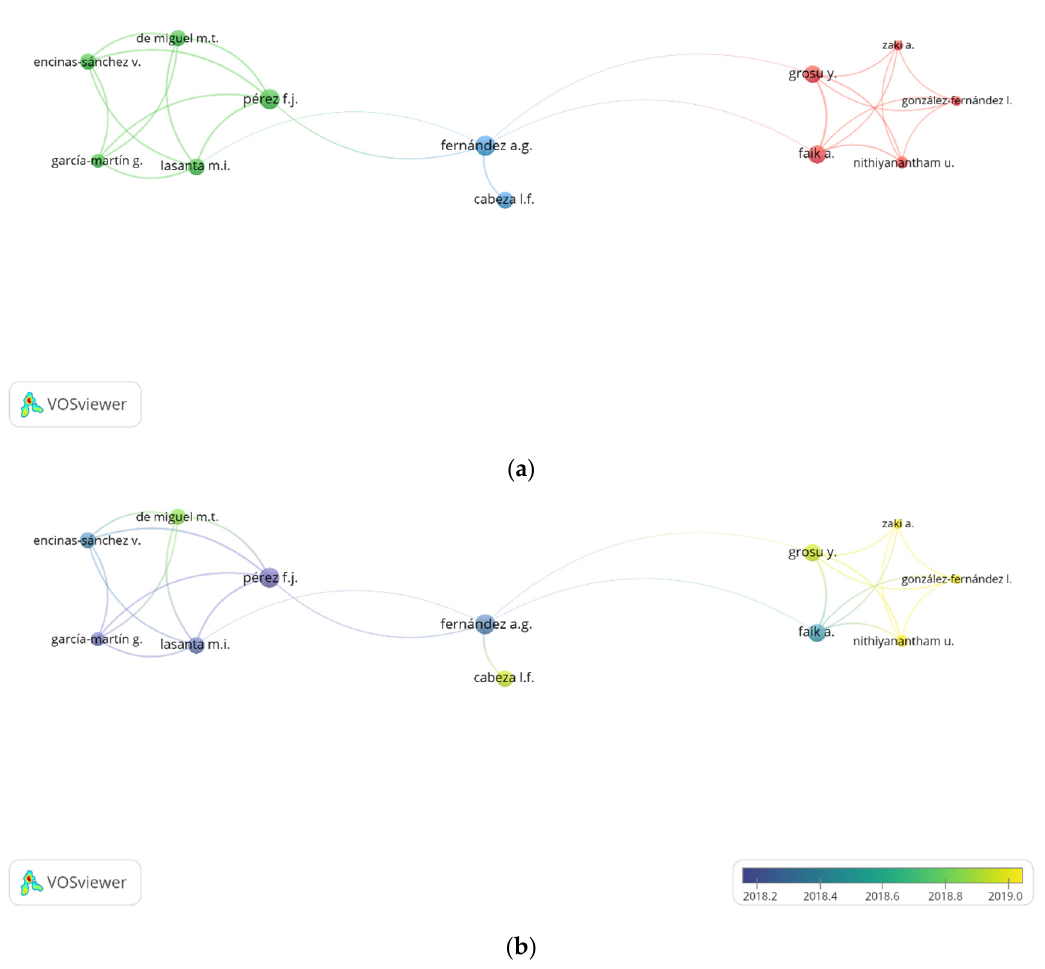
Figure 9. Relationship between authors. ( a ) Relationship between country clusters, and ( b ) Highlights of the date of publication. Error! Reference source not found. shows the mapping by VOSviewer of the litera- ture found using the query of the Scopus database.